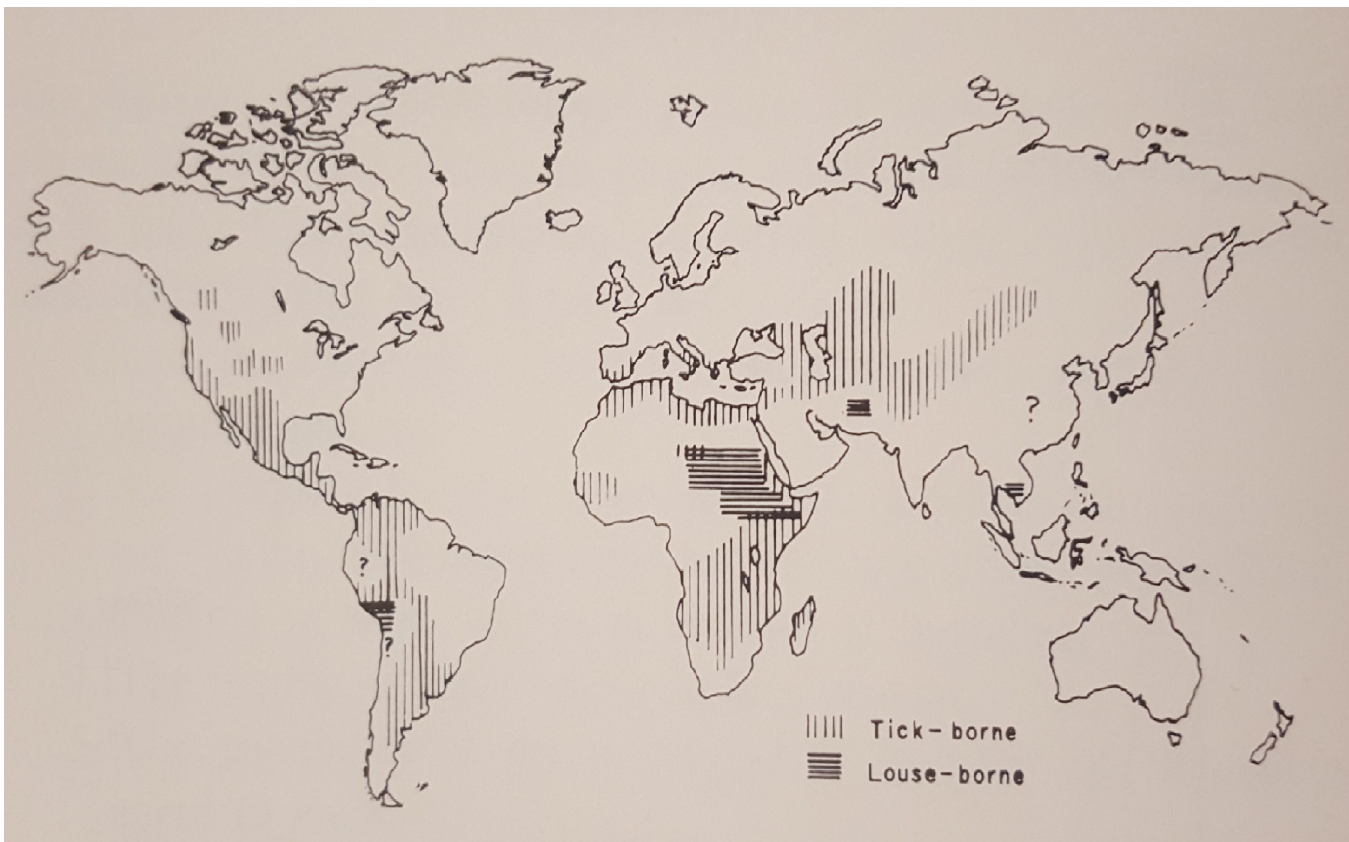
Fig 1. Assumed global distribution of TBRF and LBRF, 1950–1969 (Felsenfeld O. Borrelia ; Strains, Vectors, Human and Animal Borreliosis. St. Louis: Warren H. Green; 1971[8]).